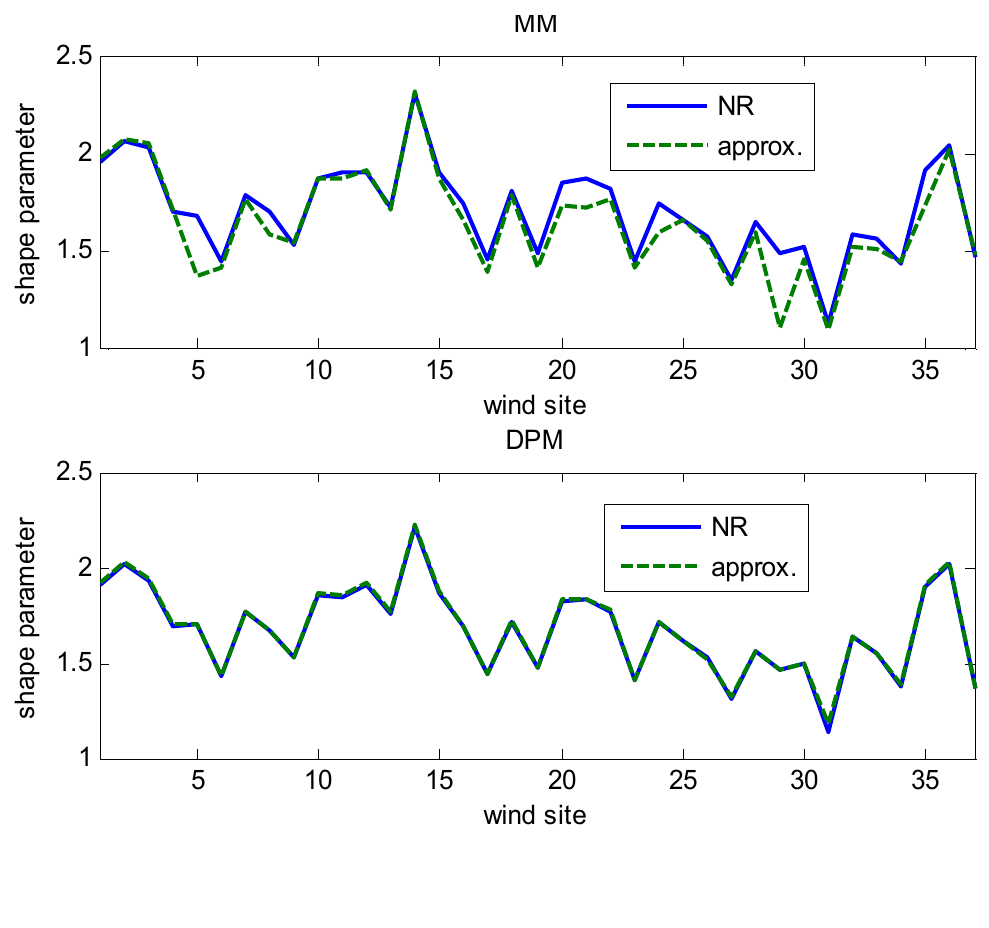
Figure 17. Shape parameter estimated with MM and density power method